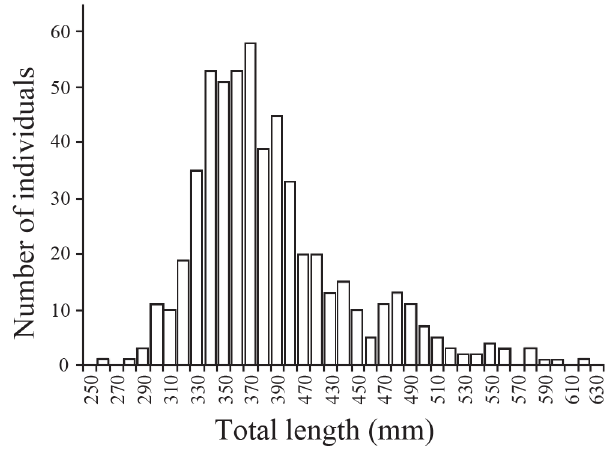
Fig. 3. Frequency distribution of total lengths of the trahira Hoplias aff. malabaricus captured during the entire sampling period.